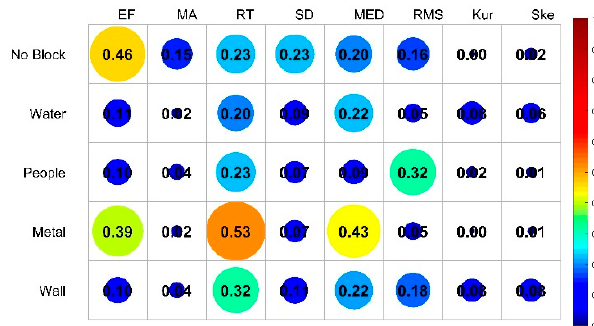
Figure 5. The relevance between features and labels.